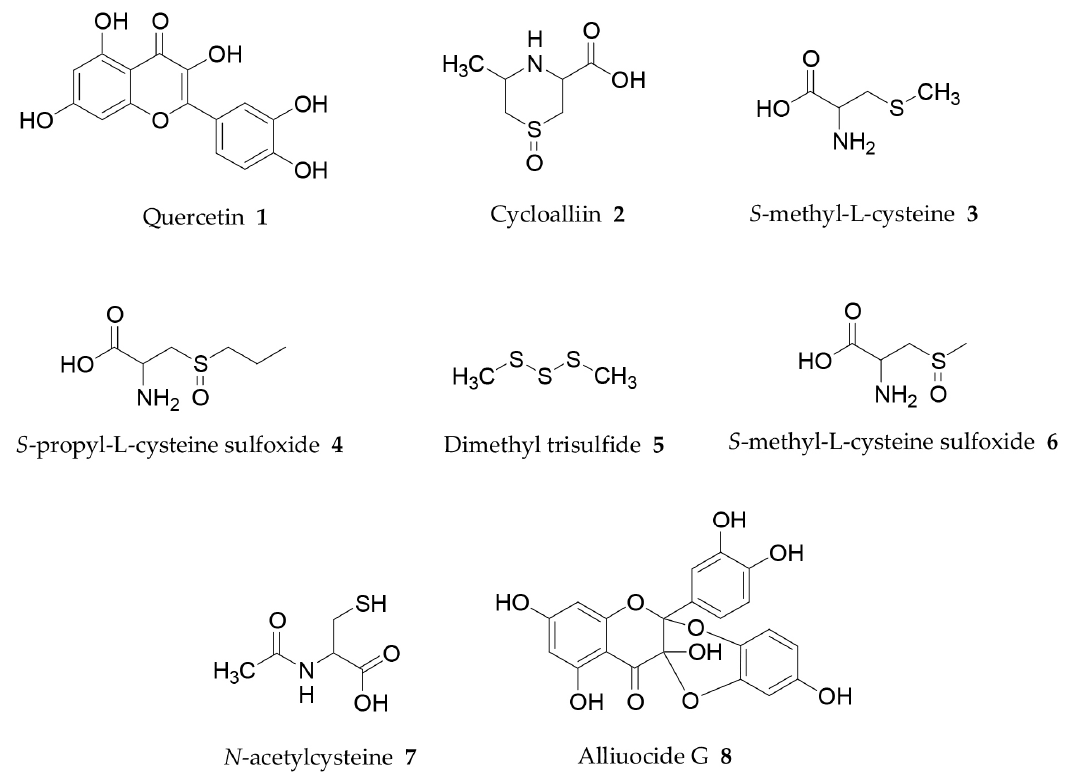
Figure 1. Structure of A. cepa chemical constituents with potential anti-obesity properties